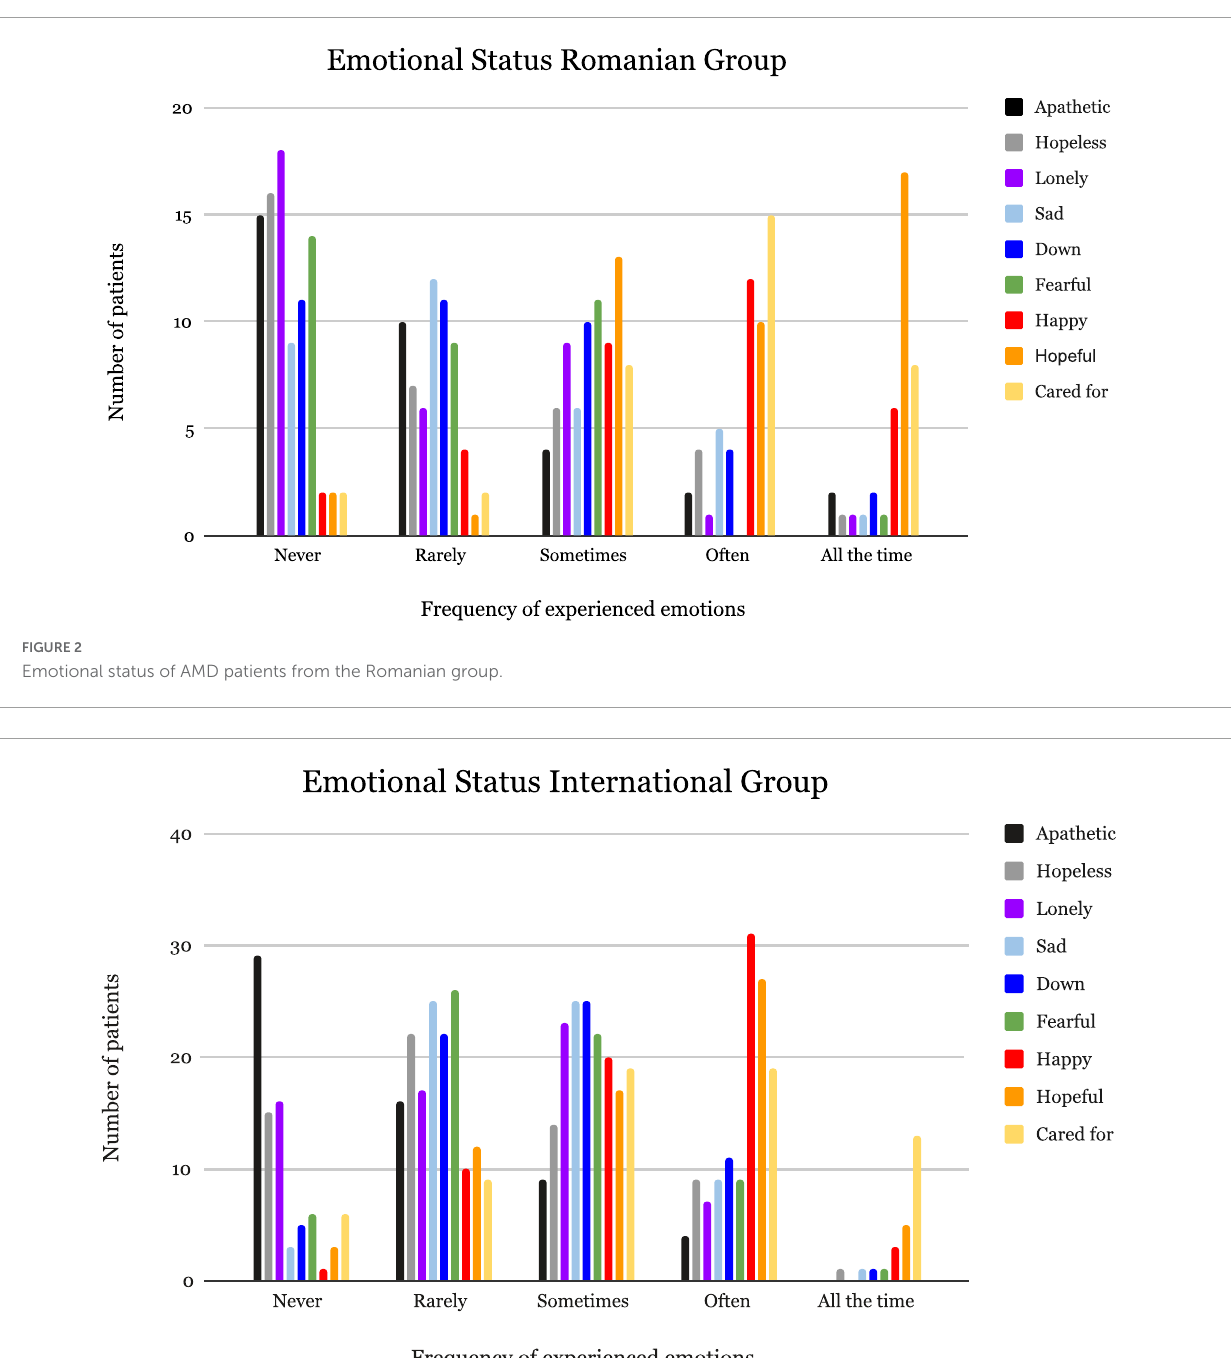
FIGURE3 Emotional status of AMD patients from the international group.